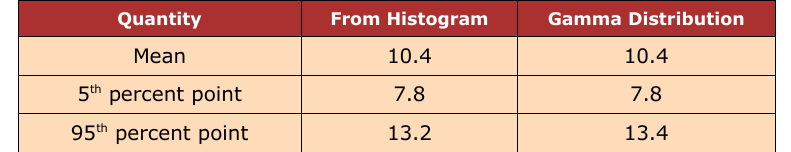
Table 2. Comparison of Histogram with Gamma Distribution of Battery Life